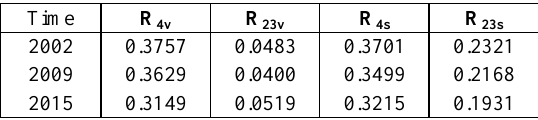
Table 2. The spectral reflectance of ETM band of 2002 and 2009, as well as OLI band of 2015 Based upon the parameters in table 2, the soil spectral reflectance corresponding to ETM4 of 2002 and 2009 as well as OLI5 of 2015 were calculated by formula (5) (6)and (7) ：